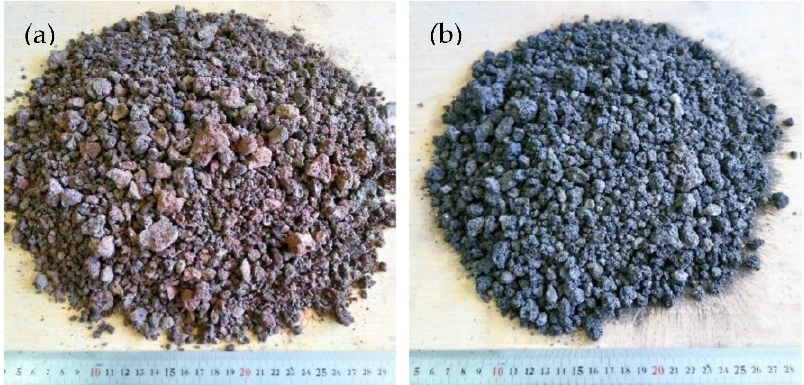
Figure 1. Sample of red scoria ( a ) and black scoria ( b ).